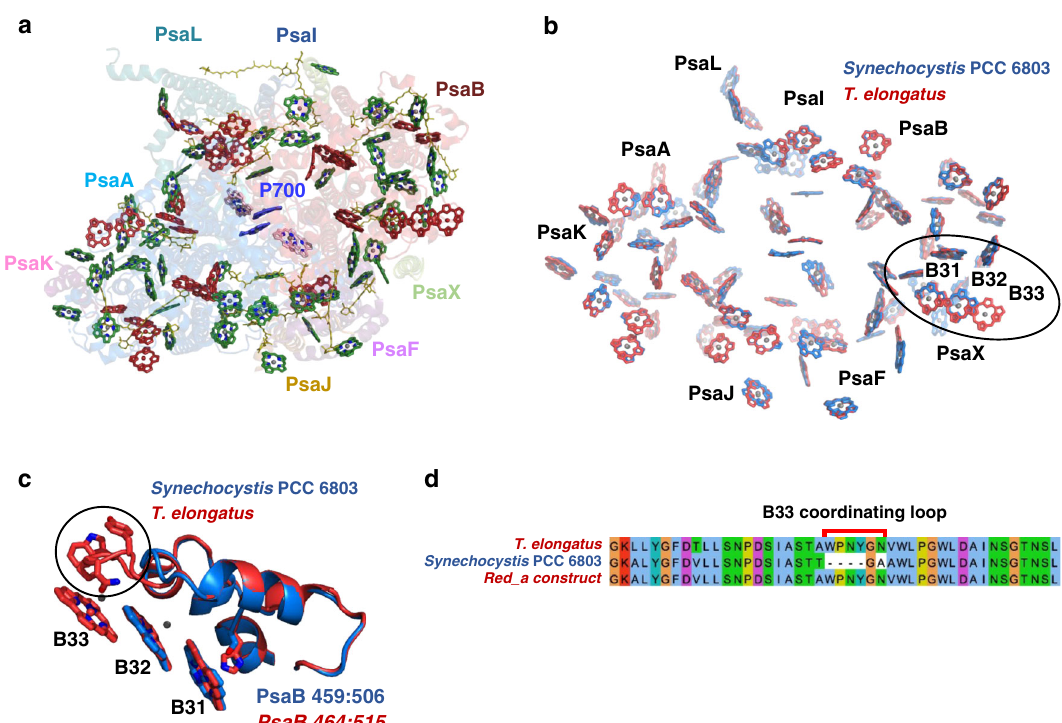
Fig. 1 Structural differences in chlorophyll positions between T . elongatus and Synechocystis PSI complexes. a The structure of a T. elongatus monomer PSI complex - core antenna Chls are shown in green, previous suggestions for red Chls are in red, β -carotenes in olive, and P700 Chls and the electron transport chain accessory Chls are in blue and pink, respectively. b Superposition of the PSI core Chls from T. elongatus (in red) on Synechocystis (in blue), the close similarity in positions results in mixed red/blue coloring on most Chls. Black ellipse marks the putative red site, B31-B32-B33 Chl trimer. c A close up of the red loop structure from both cyanobacterial species shows the highly conserved structure outside of a short loop coordinating Chl B33. d Alignments of PsaB sequences from Synechocystis, T. elongatus , and the Red_a